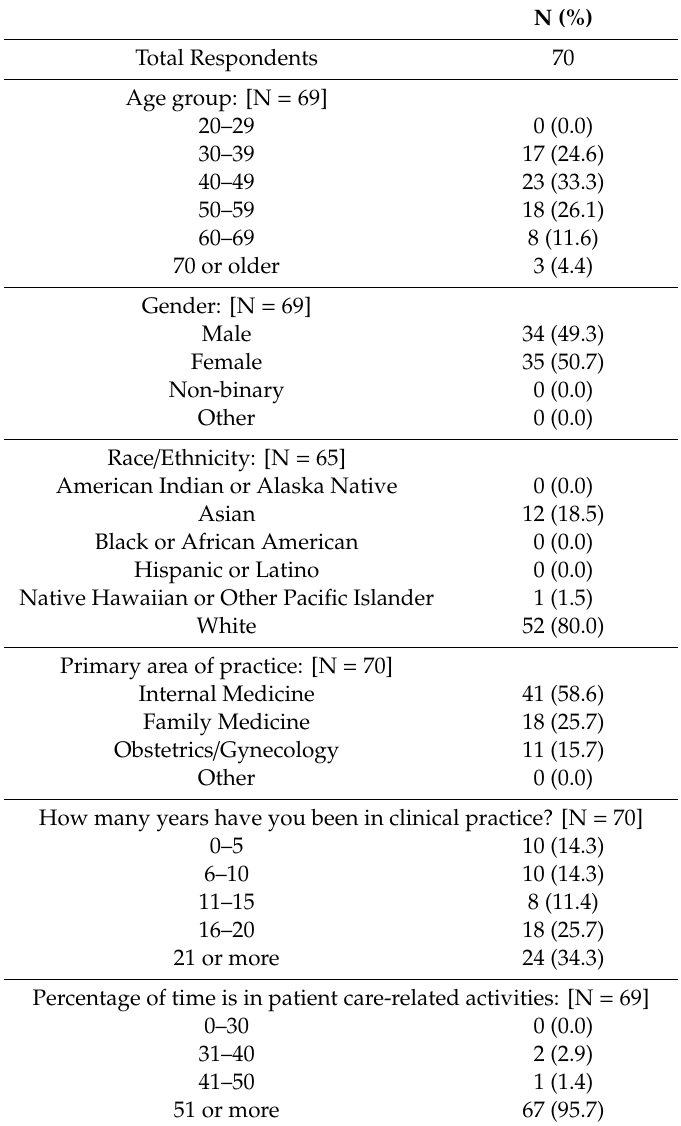
Table 2. Characteristics of survey